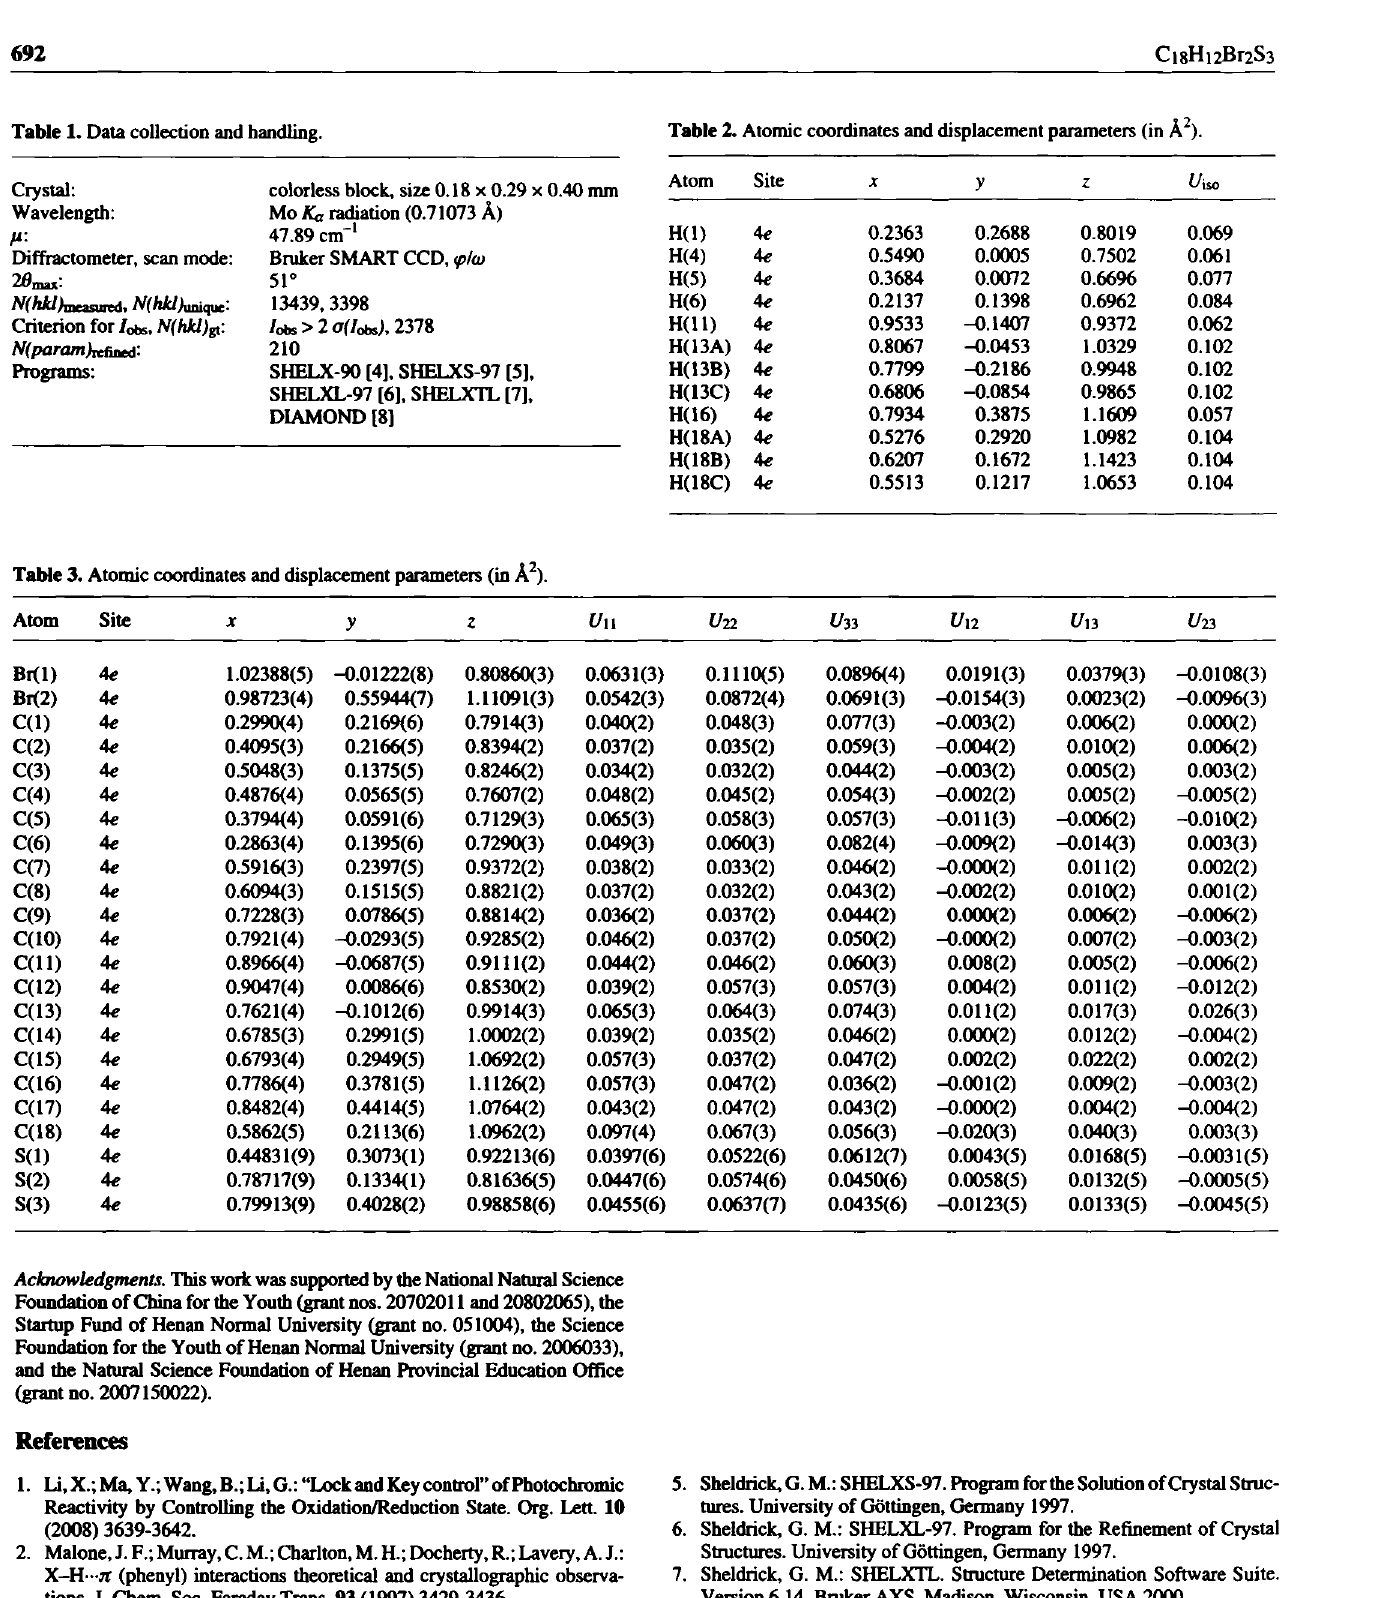
Table 1. Data collection and handling. Table 2. Atomic coordinates and displacement parameters (in Ä 2 ).